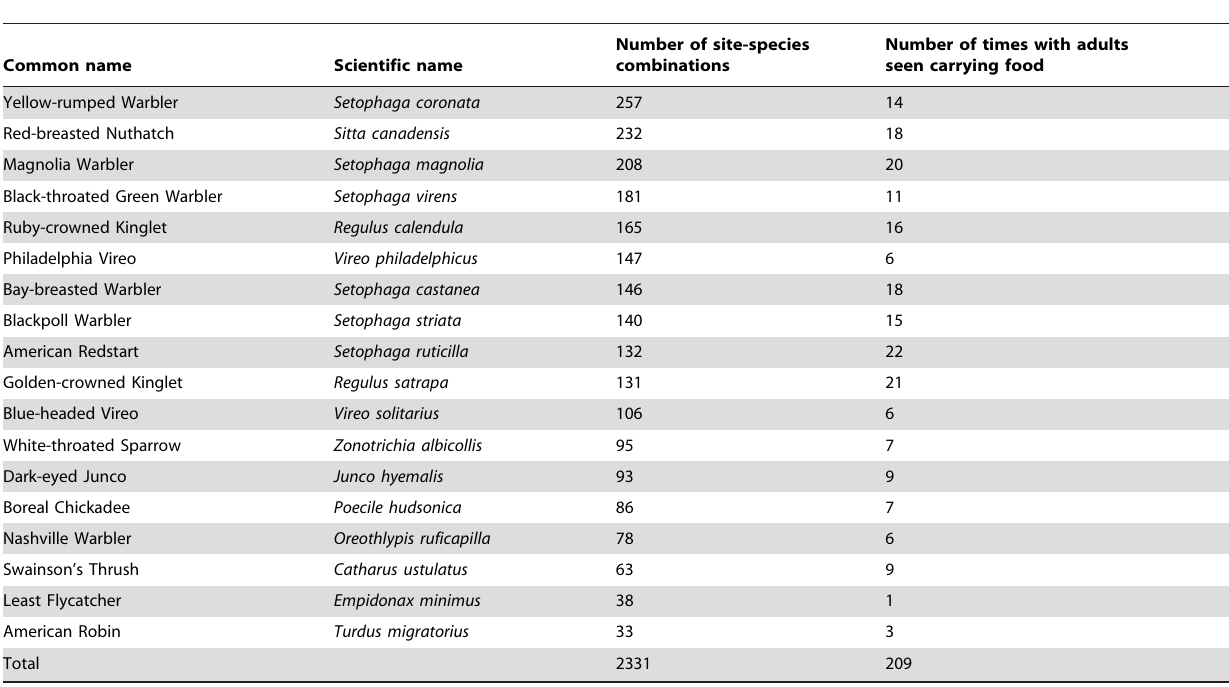
Table 1. Total number of observed adults for each species and number of cases where parental provisioning was observed during the breeding season from 2009 to 2011 at Foreˆt Montmorency (Que´bec,